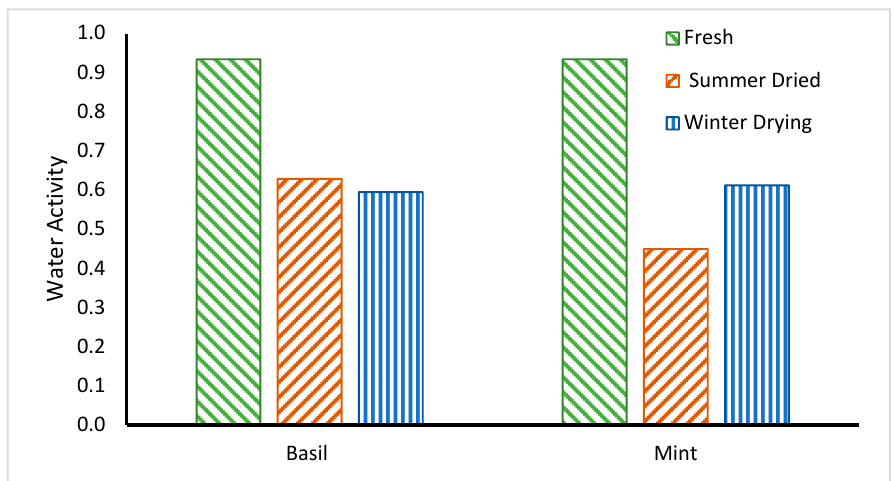
Figure 12. The water activities of Basil and Mint ( n = 3).